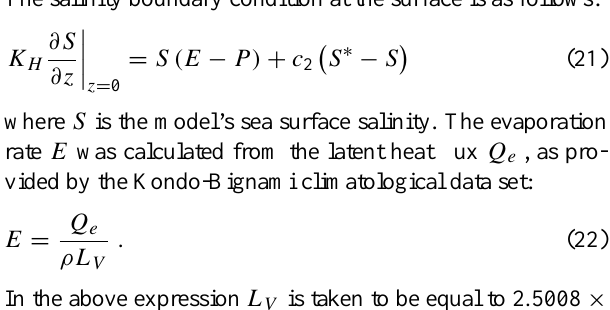
Fig. 8. (a) OGCM sea surface elevation field (5 September) as mapped onto ALERMO’s domain (b) ALERMO free surface elevation after 20 days of climatological integration (units are